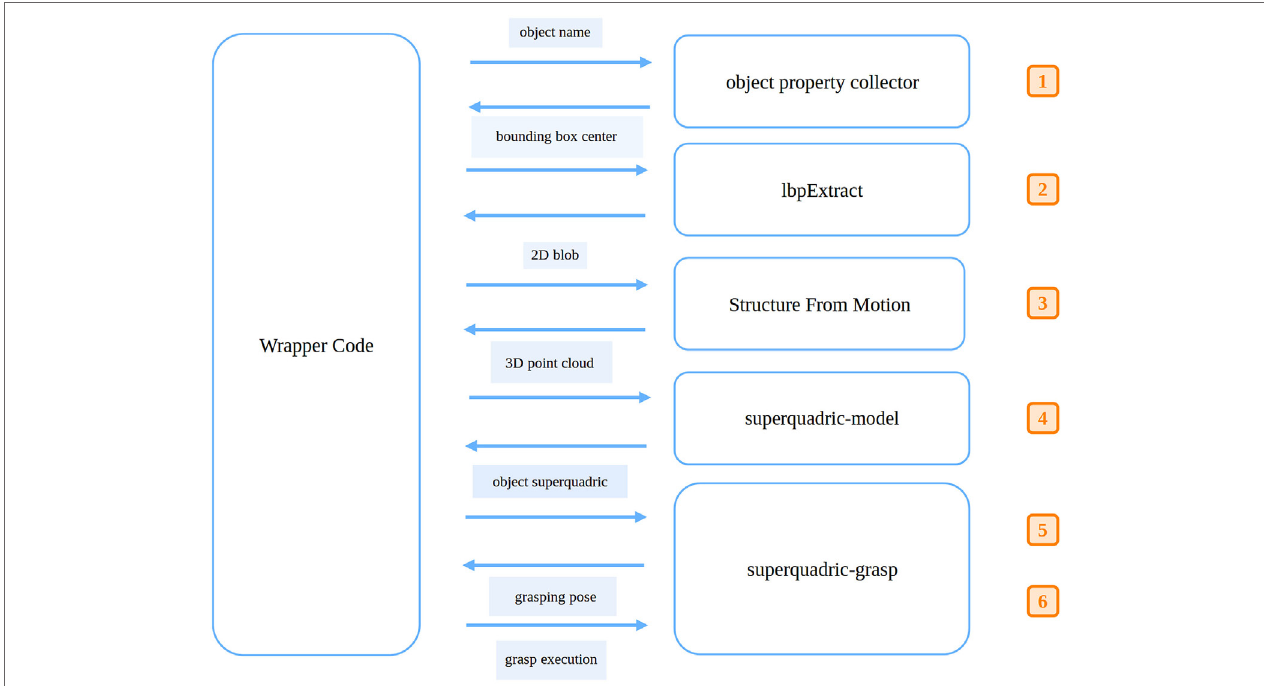
FIGURe 2 | Modules communication for the implementation of the modeling and grasping pipeline. The wrapper code manages the interaction between external modules and the superquadric-model and superquadric-grasp frameworks. Pipeline steps enumerated as in Section 3: (1) The wrapper code asks the object property collector for the bounding box information of the object. (2) Given that, lbpExtract module provides the 2D blob of the object. (3) The wrapper code sends the 2D blob of the object to the Structure From Motion module for getting the relative 3D point cloud. (4) The 3D point cloud is then sent to the superquadric-model for computing the superquadric modeling the object. (5) The wrapper code sends the estimated superquadric to the superquadric-grasp module, which computes suitable poses. (6) Finally, the superquadric-grasp is asked to perform the grasping